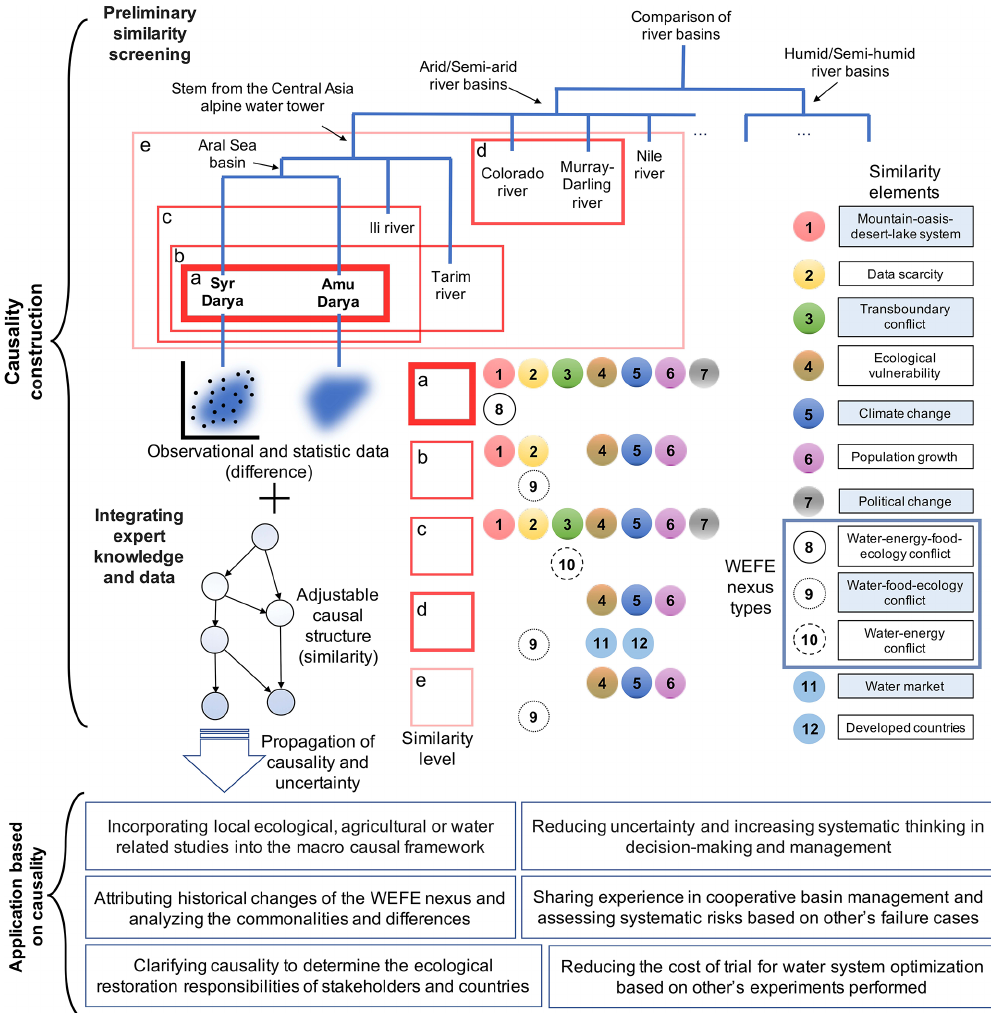
Figure 2. The new generalized basin-wide water–energy–food–ecology nexus comparison framework based on combining the similar causal structure and data differences. The upper tree structure shows the a priori classification of river basins, and the arid/semi-arid branch is more subdivided. The lower left part illustrates the operation mode of the new basin comparison framework: combining the similar causal structure determined by experts and the multi-dimensional observation dataset containing differences. The red boxes marked with a–e contain elements identified by the 1–12 serial numbers on the right that measure similarities at different levels. Numbers 8–10 show the different water–energy–food–ecology-related nexus types adjusted according to boxes a–e. River basins in the same red box can be compared by a specific structure of causality generated by the elements the box contains. The bottom part shows the significance of the application under this new